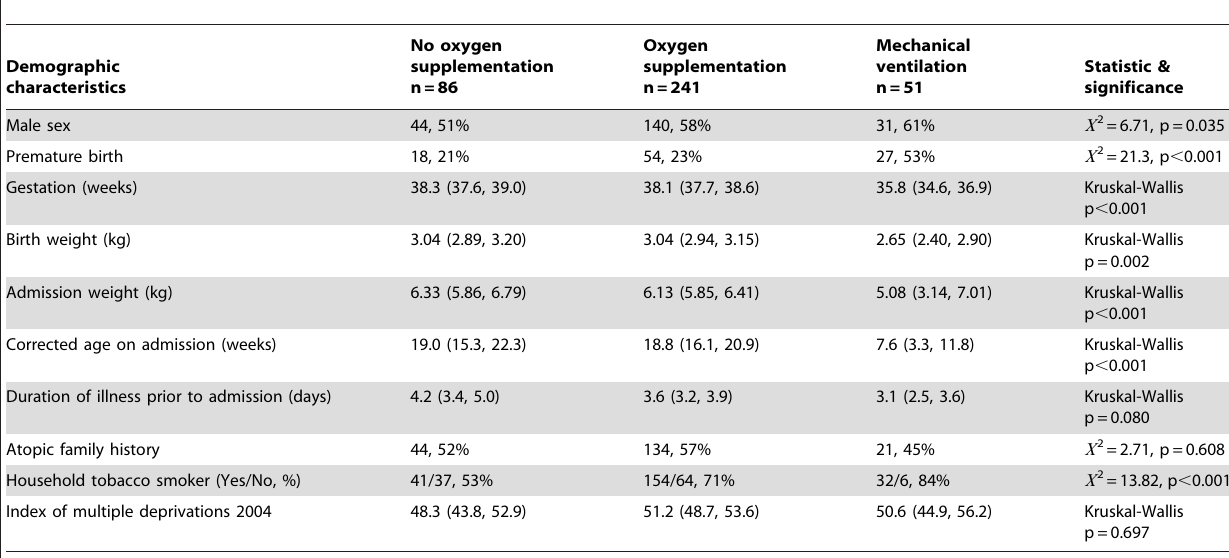
Table 1. Demographic characteristics of 378 infants admitted with bronchiolitis and univariate